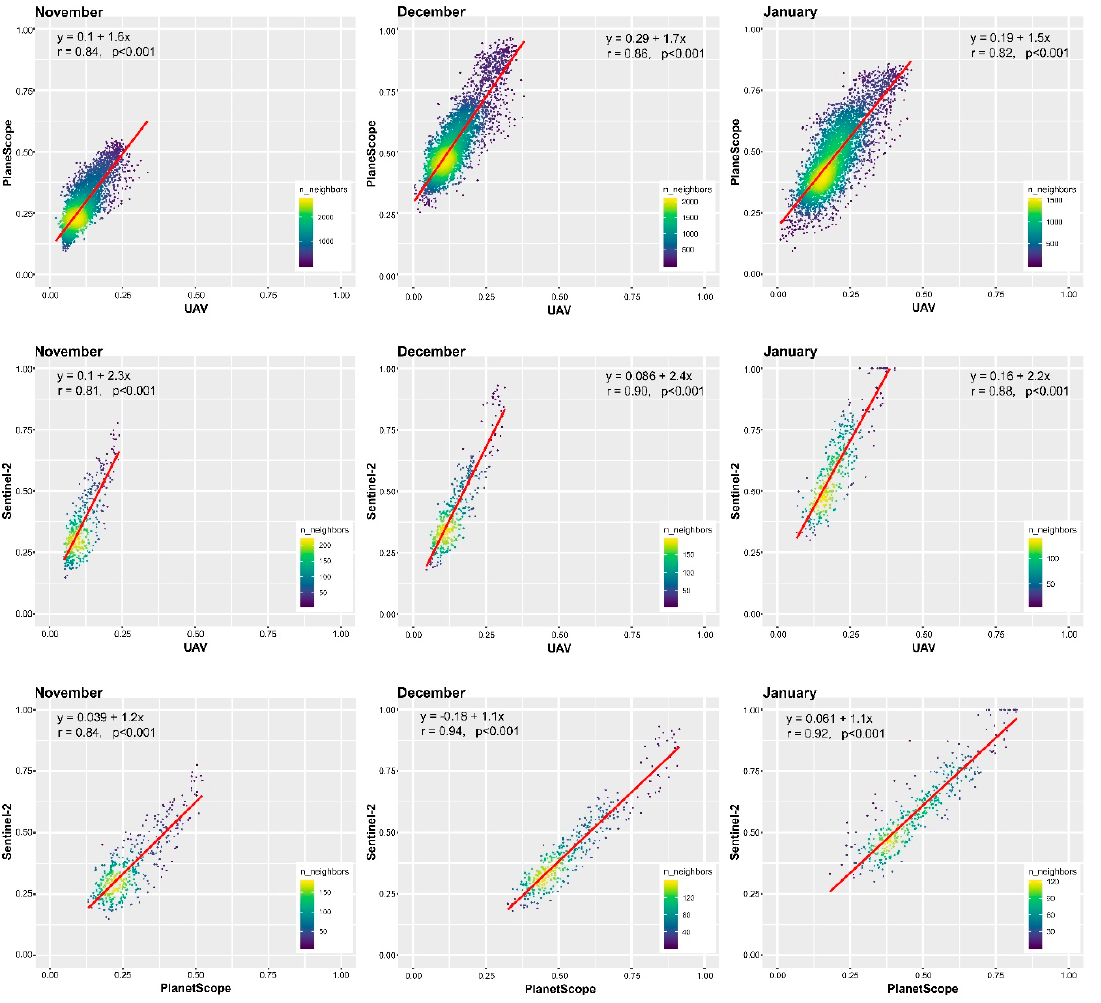
Figure 6. Scatter plots of SAVI values from the UAV, PlanetScope, and Sentinel-2 (S2) map in three months surveyed.